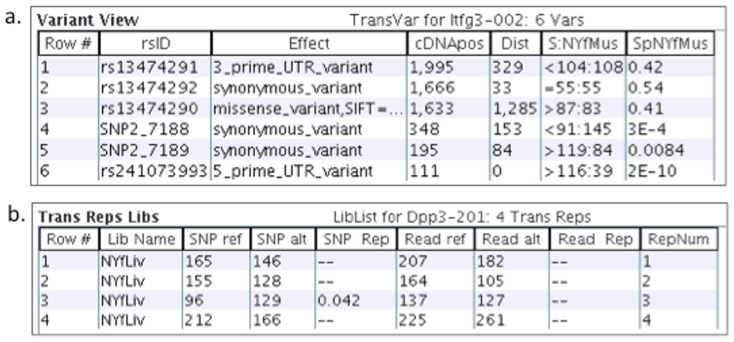
viewAW drilling down into the data.(a) The table shows the variants for an AI transcript. The S:NYfMus column displays the ref:alt SNP coverage for library NYfMus, and the SpNYfMus column shows the corresponding p-values. There are three AI SNPs, where two are ref> alt and the other is alt <ref. (b) The table shows the replicate counts for a transcript. The “SNP Rep” column contains a p-value for any replicate that has significantly different counts from the other replicates.